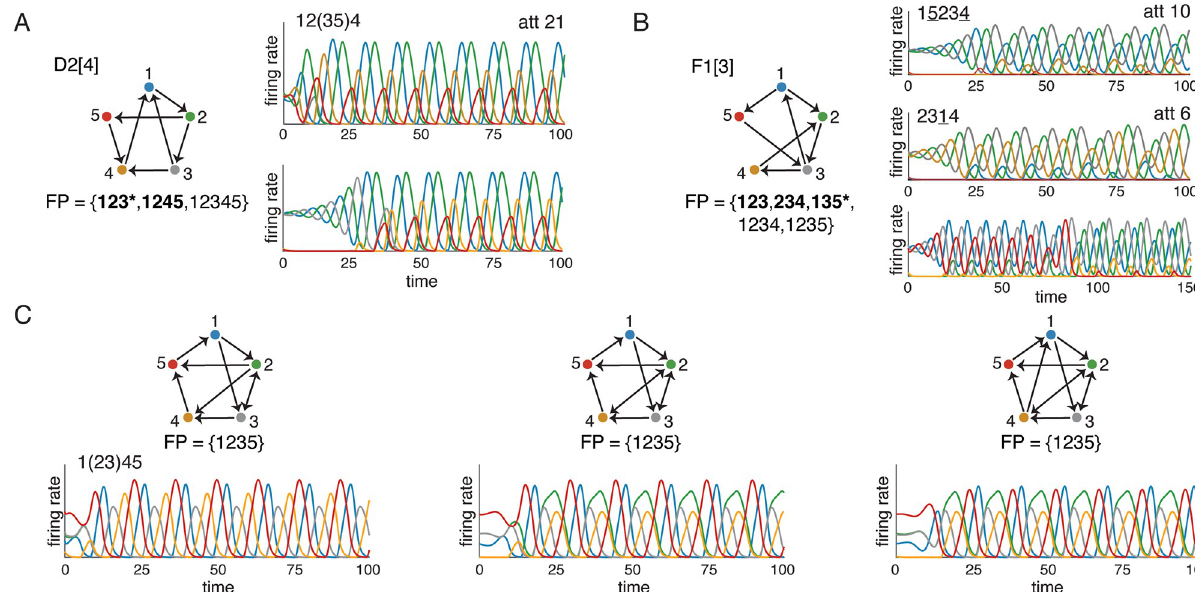
Fig 8. Failures of attractor prediction from core fixed points. (A) The graph D2[4] has two core fixed points, but only one attractor (att 21, top right). Initializing near the core fixed point with support 123 leads to activity that eventually falls into the 1245 attractor (bottom right). (B) The graph F1[3] has three core fixed points, but only the first two have corresponding attractors. Initializing near the fixed point for 135 initially appears to fall into an attractor supported on 135 (bottom right). However, after time these solutions converge to the attractor supported on 123. The missing attractors in A-B are called “ghost attractors.” In a higher δ parameter regime, however, the core fixed points do yield their own attractors (see Supporting information). (C) Three graphs that are not oriented: each one has the bidirectional edge 2 $ 3. These graphs each have a unique fixed point, supported on 1235, but it is not a core fixed point. Nevertheless, the corresponding networks all have dynamic attractors.